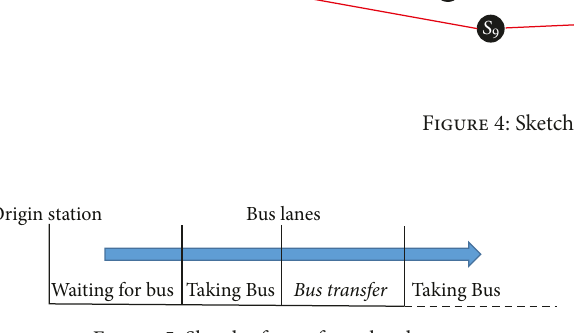
Figure 5: Sketch of transfer to bus